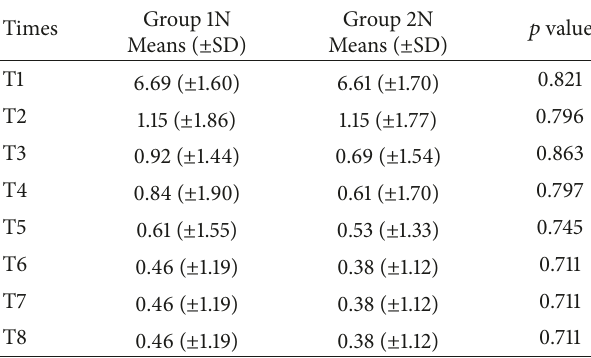
Table 2: Comparison of visual analog scale (VAS) scores (0–10) according to the follow-up time between groups 1N and 2N.